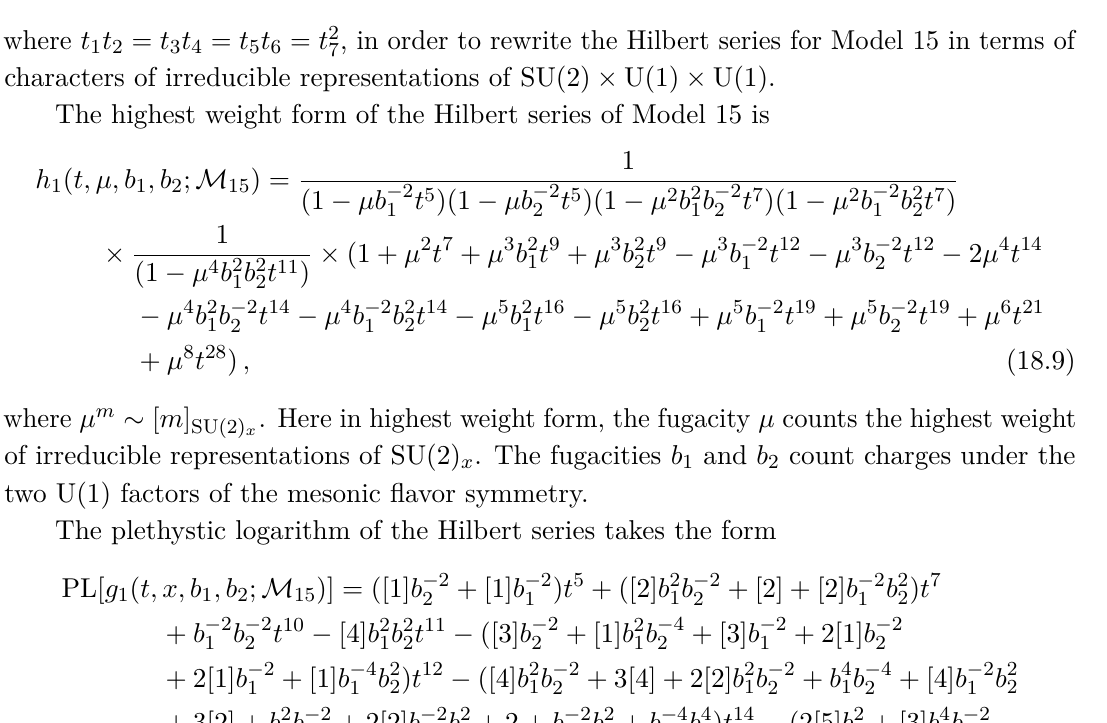
Figure 39 . Toric diagram for Model